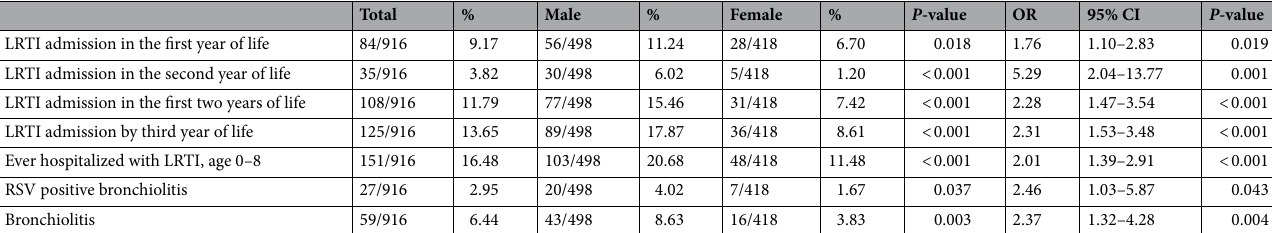
Table 1. Comparisons of lower respiratory tract infection (LRTI) hospital admissions, bronchiolitis and RSV positive bronchiolitis cases in female and male cohort participants. Differences were assessed through χ 2 and Fishers exact test for sample size > 5 and ≤ 5, respectively, and logistic regression analysis (reference group: males). OR odds ratio, 95% CI 95% confidence